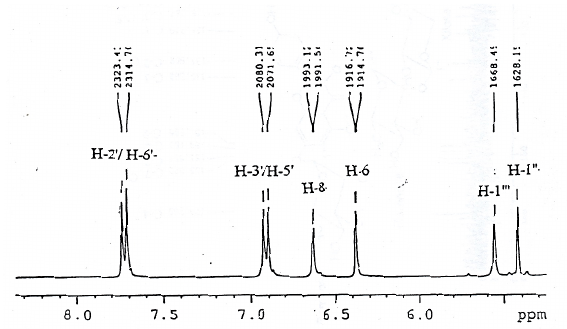
Figure S3: 1 H-NMR spectrum of sagittatin A (300 MHz; CD 3 OD). Magnification of 5.5 - 8.5 ppm region.